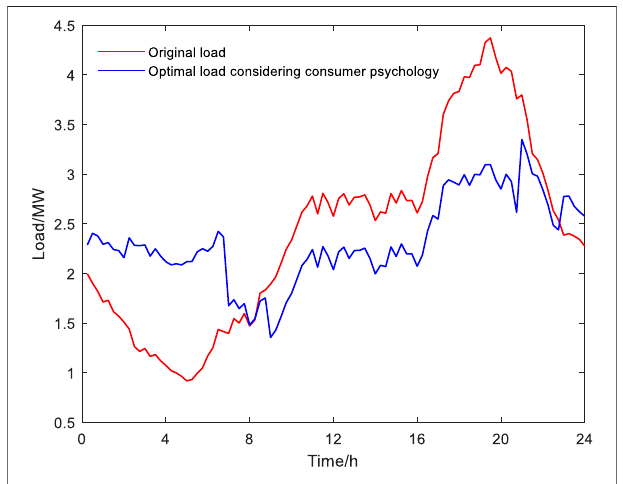
FIGURE 12 | Total load before and after time-of-use price optimization.